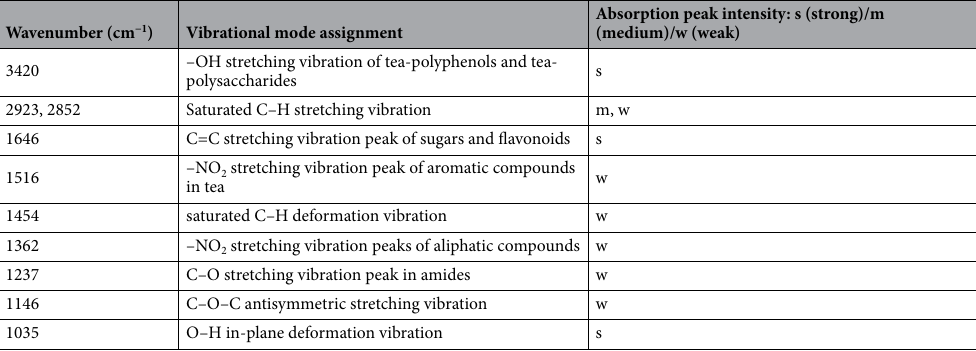
Table 1. Band assignments for the FTIR spectra obtained from modern tea.